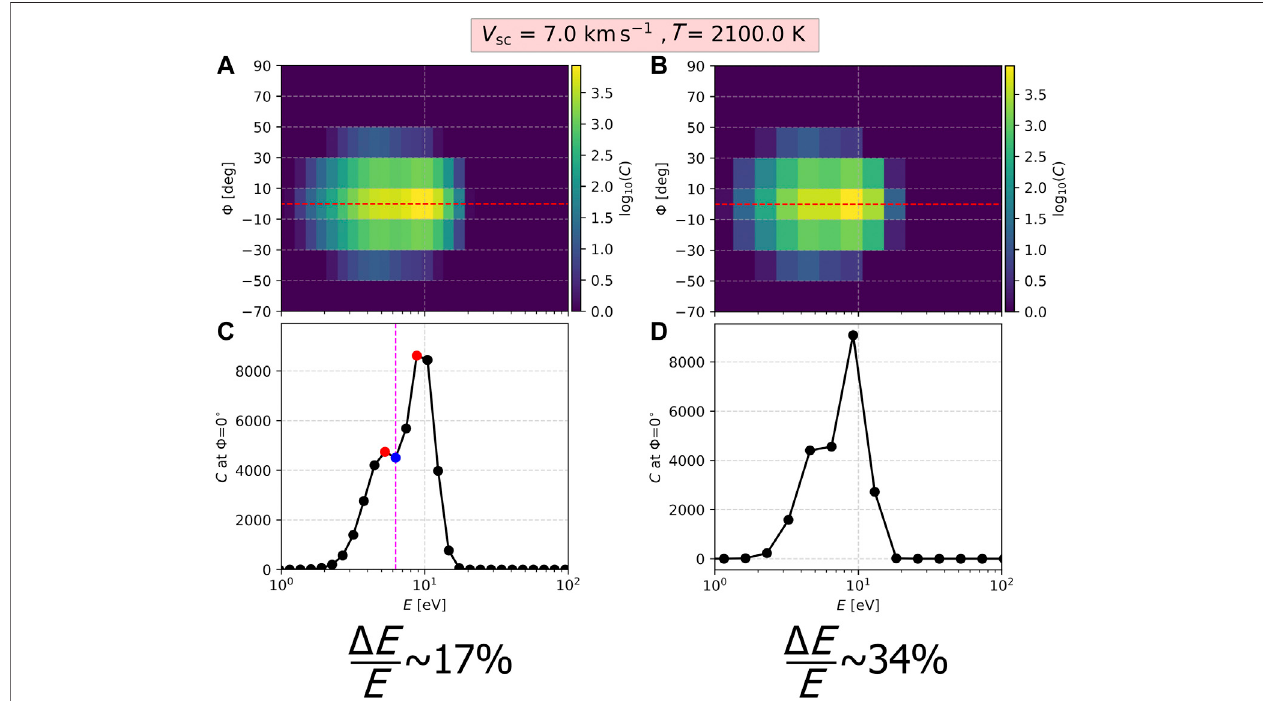
FIGURE 9 | Modeled C ( E , Φ ) observations for V sc = 7 kms − 1 and T = 2100 K (~0.18 eV) for both OH − and H 2 O-OH − plasma ions, obtained by an electrostatic analyzer instrument with energy resolution (A) Δ E ~0.17and (B) Δ E ~0.34. Panels (C,D) show the corresponding C ( E , Φ (cid:1) 0 ° ) E E